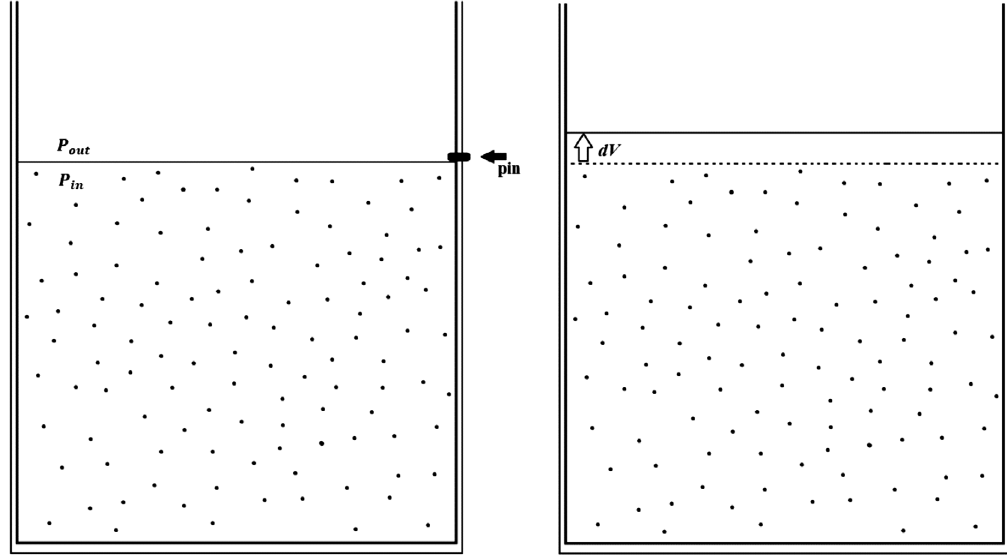
FIG. 6. A hot gas at a higher pressure than the outer surroundings inside a piston. A pin holds the piston in place. When the pin is removed, the gas begins a spontaneous expansion. An infinitesimal change in volume is shown on the right half of the